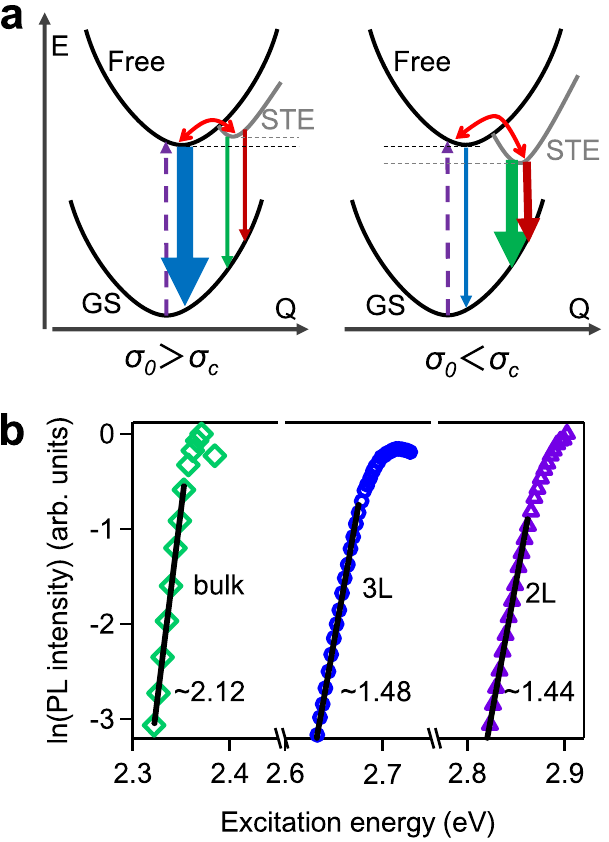
Fig. 4 Urbach rule in lead halide perovskites. a Scheme of the energy diagram of free and STE state in different regimes and dominant relaxed species. b Urbach tail and fi tting according to Eq. 4 of different thickness